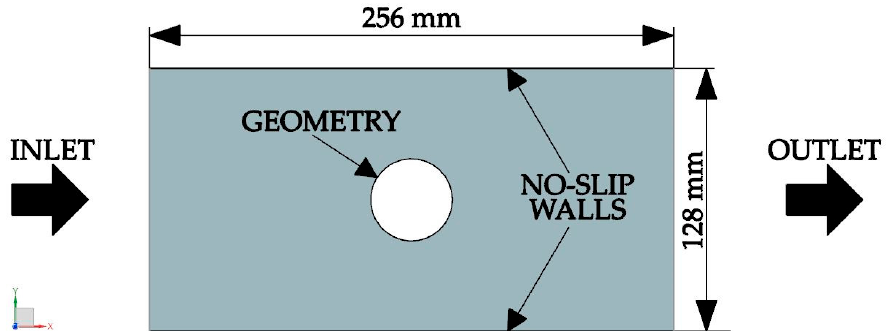
Figure 1. Numerical